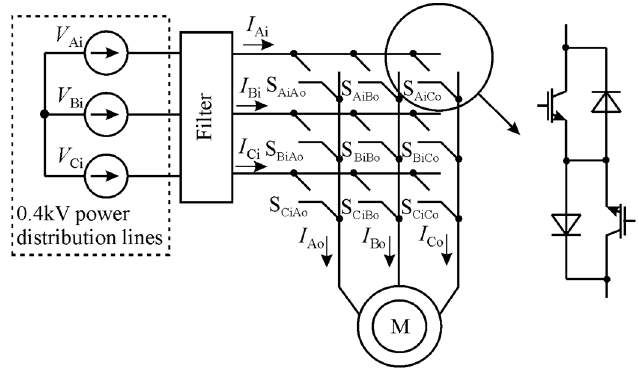
Figure 7. Diagram of MC-based induction motor VFD